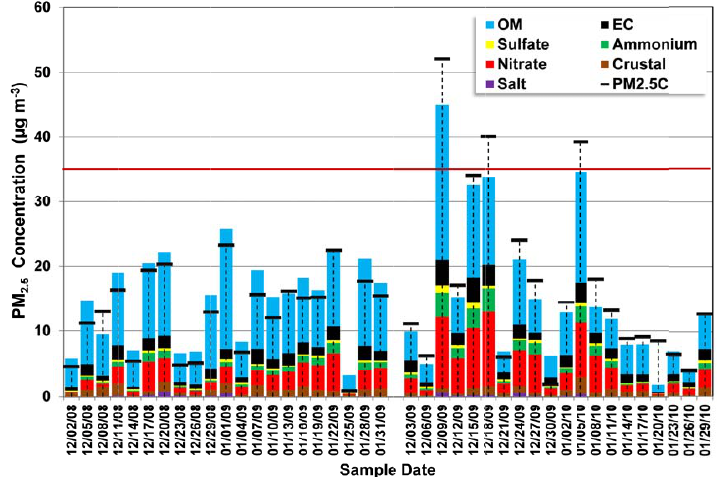
Fig. 4. PM 2 . 5 mass reconstruction compared to speciation mass (PM 2 . 5 C) for winter 2008/2009 and 2009/2010. The red line indicates the USEPA 24-h PM 2 . 5 National Ambient Air Quality Standard (NAAQS) of 35µgm − 3 . The 15 December 2009 sample exceeds the NAAQS by FRM mass but not by speciation mass (34µgm − 3 ) . OM = 1.4×[OC]; Crustal Material = 2.2 ×[Al] + 2.49×[Si] + 1.64×[Ca] + 2.42 ×[Fe] + 1.94×[Ti]; and Salt = [Na + ] + [Cl].